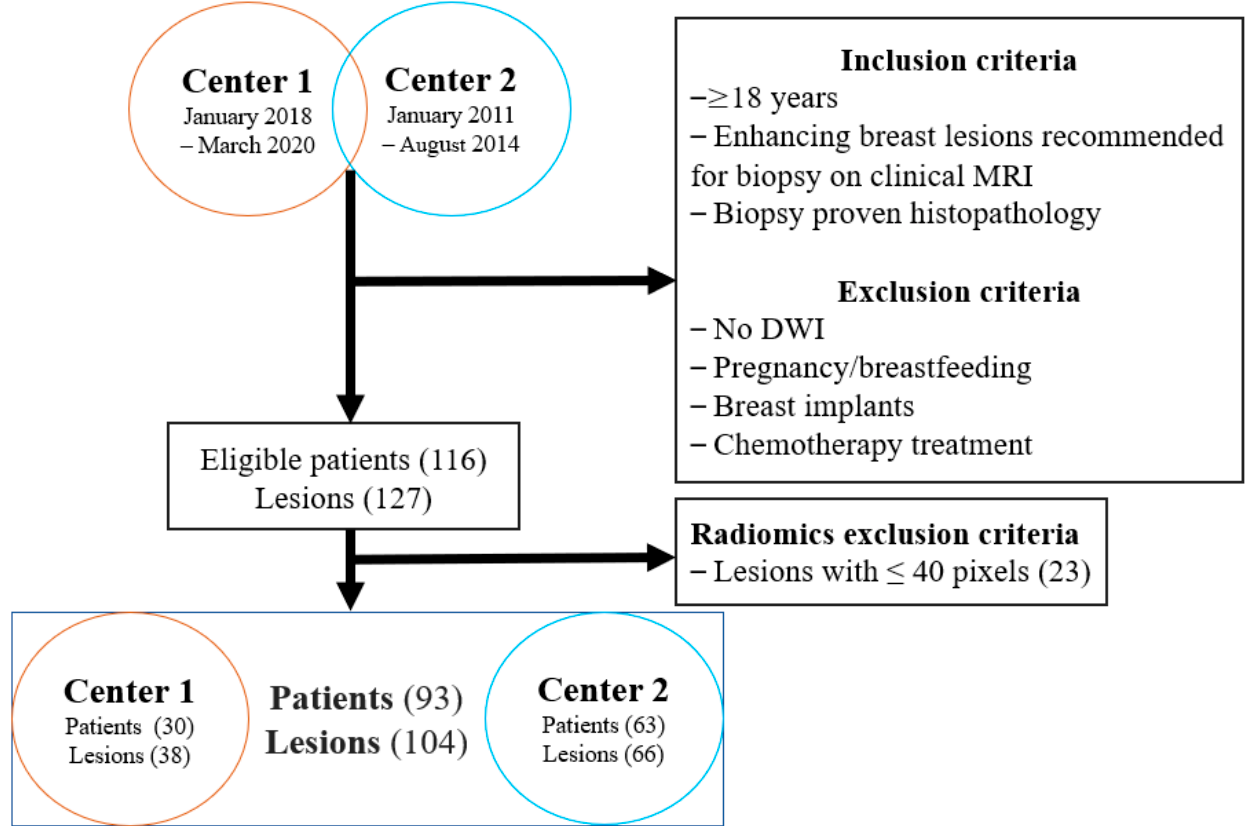
Figure 1. Flowchart for the selection of patients in the study. DWI, diffusion-weighted imaging.